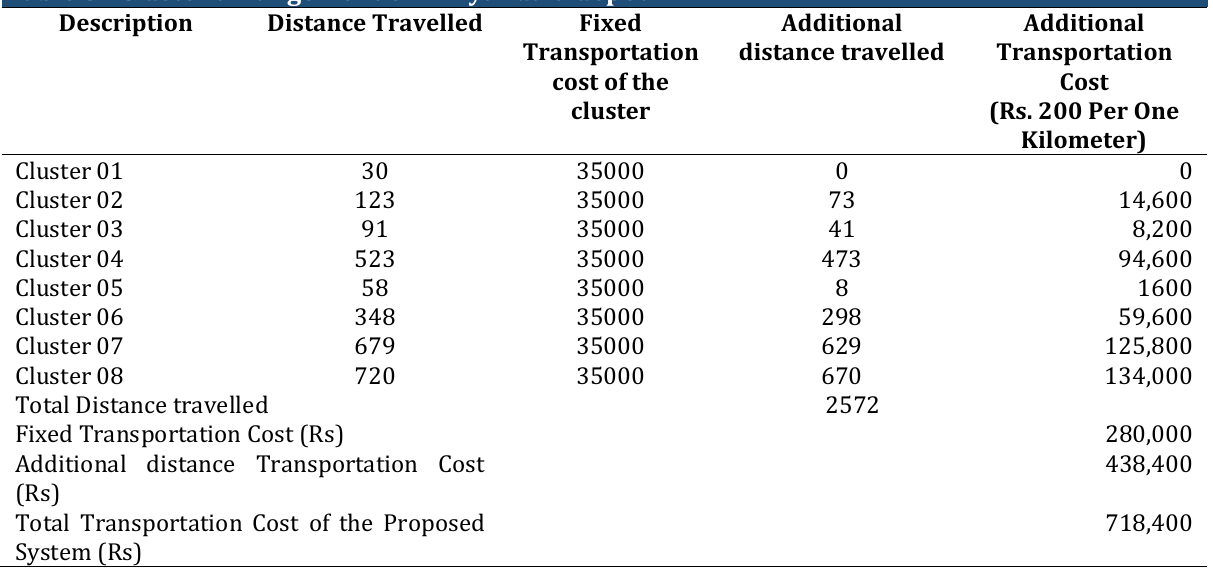
Table 5: Cluster arrangement on Piliyandala